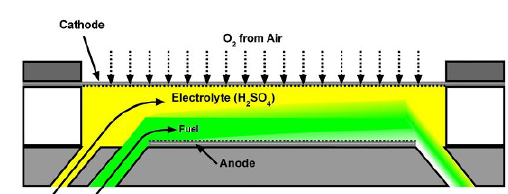
Figure 3. Microfluidic air-breathing direct methanol and formic acid fuel cell system design [15], Copyright Elsevier